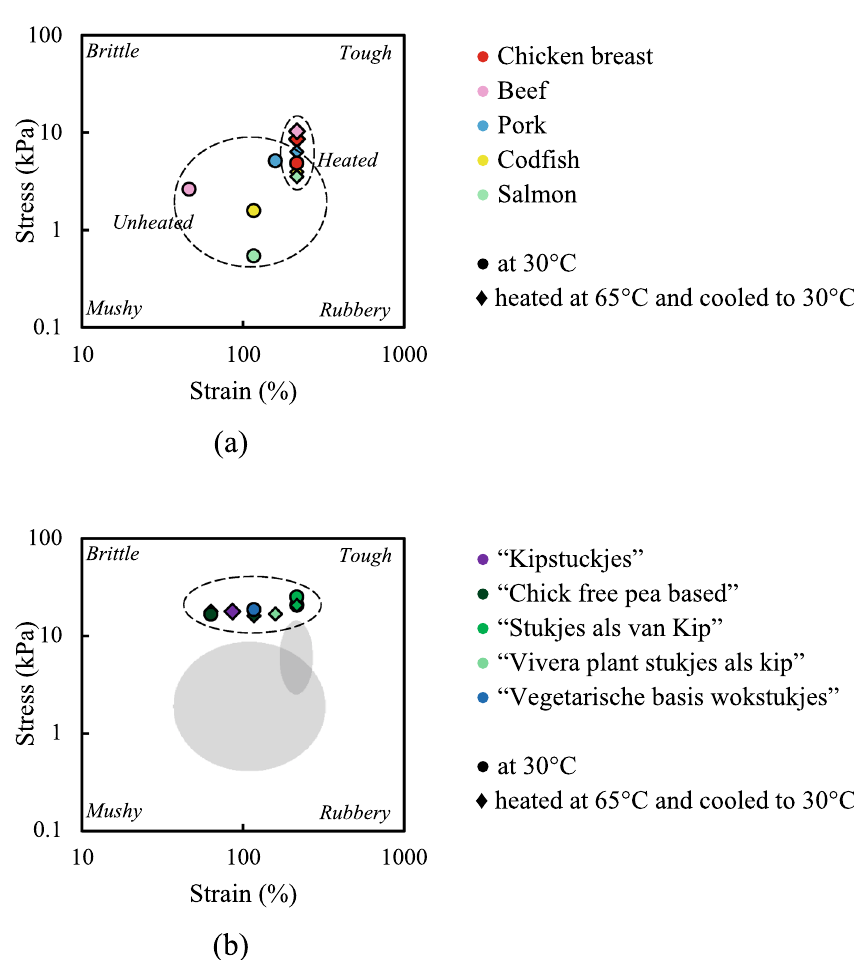
Figure 3. Texture map at the crossover point for meat ( a ) and meat analogues ( b ) heated at 30 °C and heating to 65 °C, and cooling to 30 °C. Note that the scales of the x and y axes are different from those in Fig. 2. Lines are drawn to guide the eye and shows the outline, the grey area in the texture map of meat analogues shows the outline of meat products shown in ( b